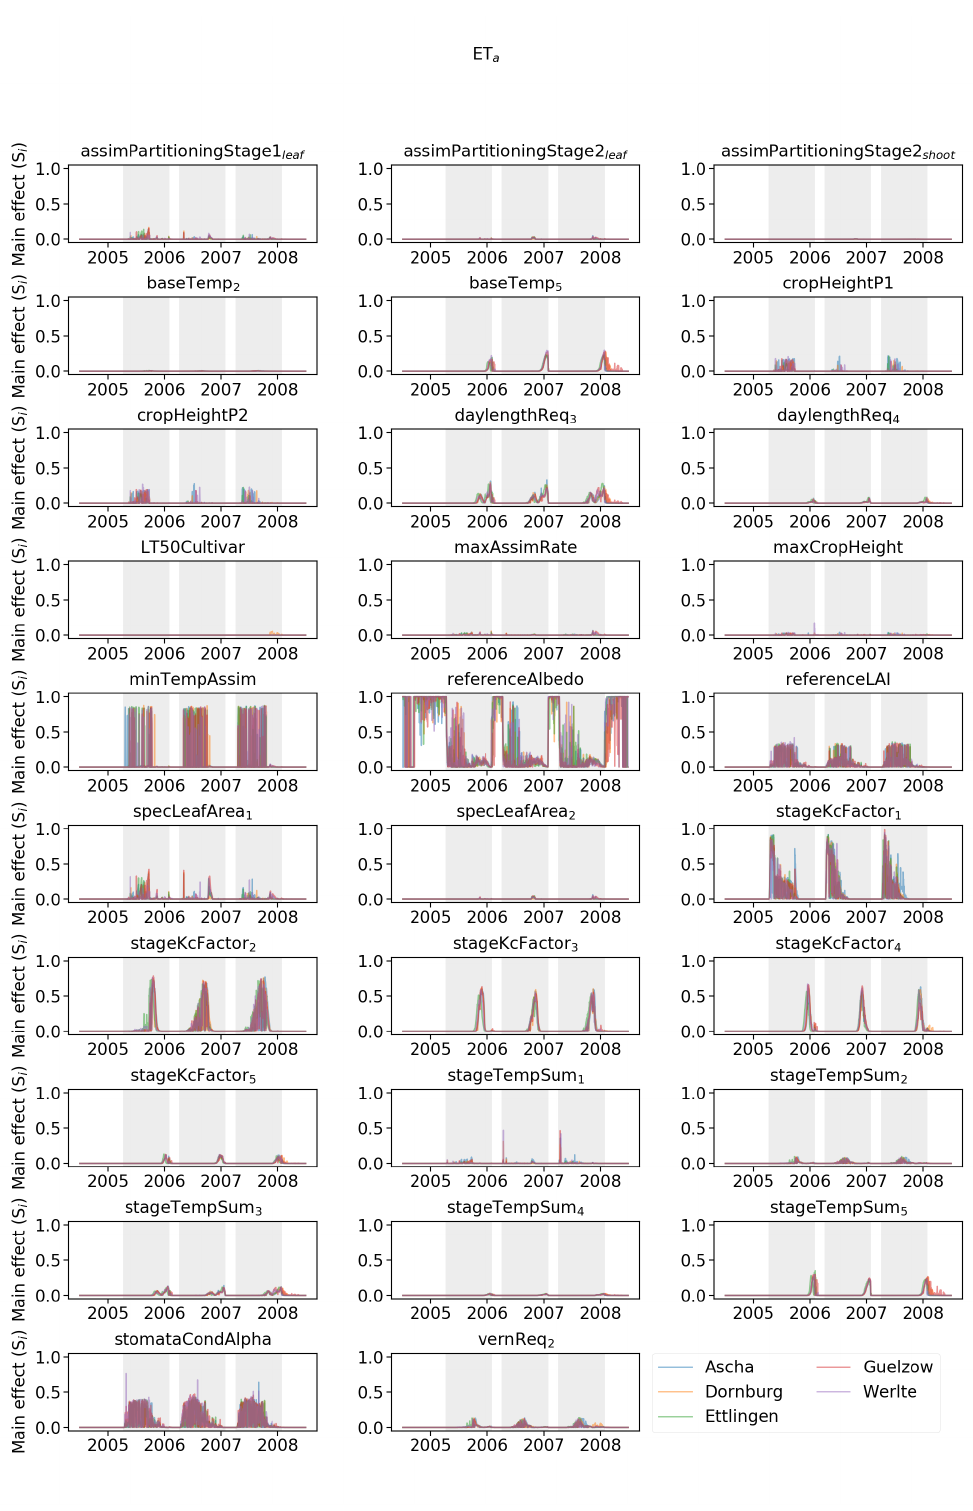
Figure A4. Daily S i values calculated using the extended FAST method for ET a differentiated among the different